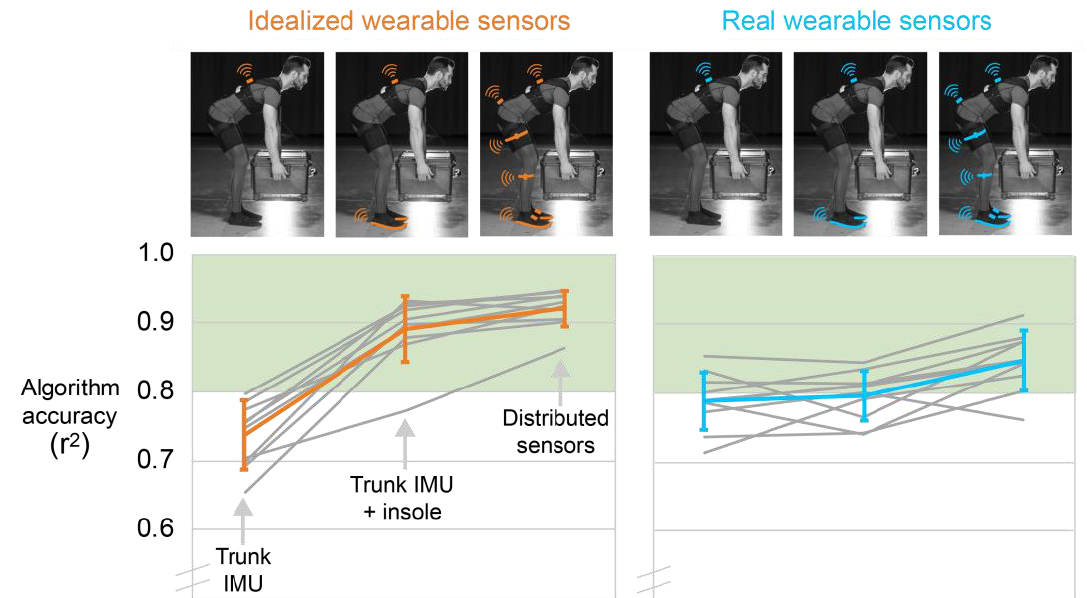
Figure 7. Side-by-side comparison of algorithm performance using idealized versus real wearable sensor signals. Gray lines are each of the 10 participants’ accuracy results, and colored lines are the average (and standard deviation) across the 10 participants. Results using idealized wearable sensors are shown on the left (orange) and results using real wearable sensors are shown on the right (blue).